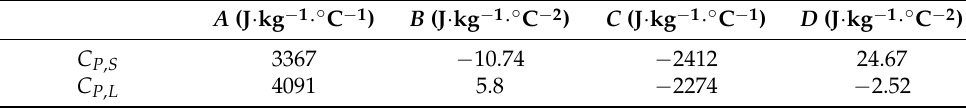
Table 1. Empiric parameters for solid and liquid specific heat determination.